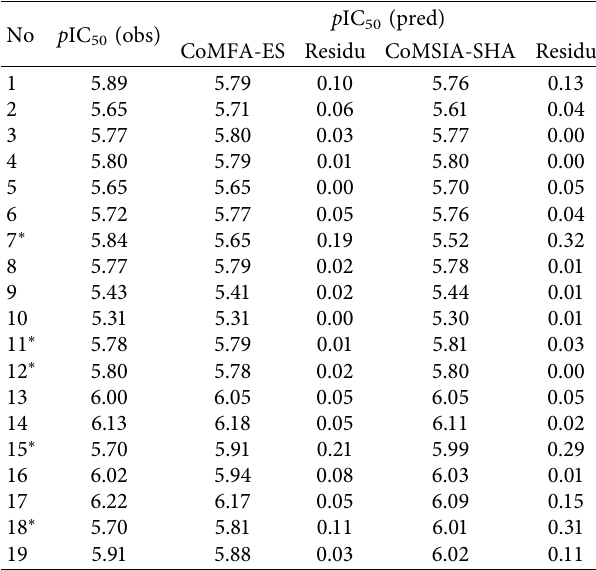
Figure 9: Main structure-activity relationships derived from this study. Table 5: Anticancer activity ( p IC 50 ) of compounds in the training set and the test set for the final CoMFA and CoMSIA